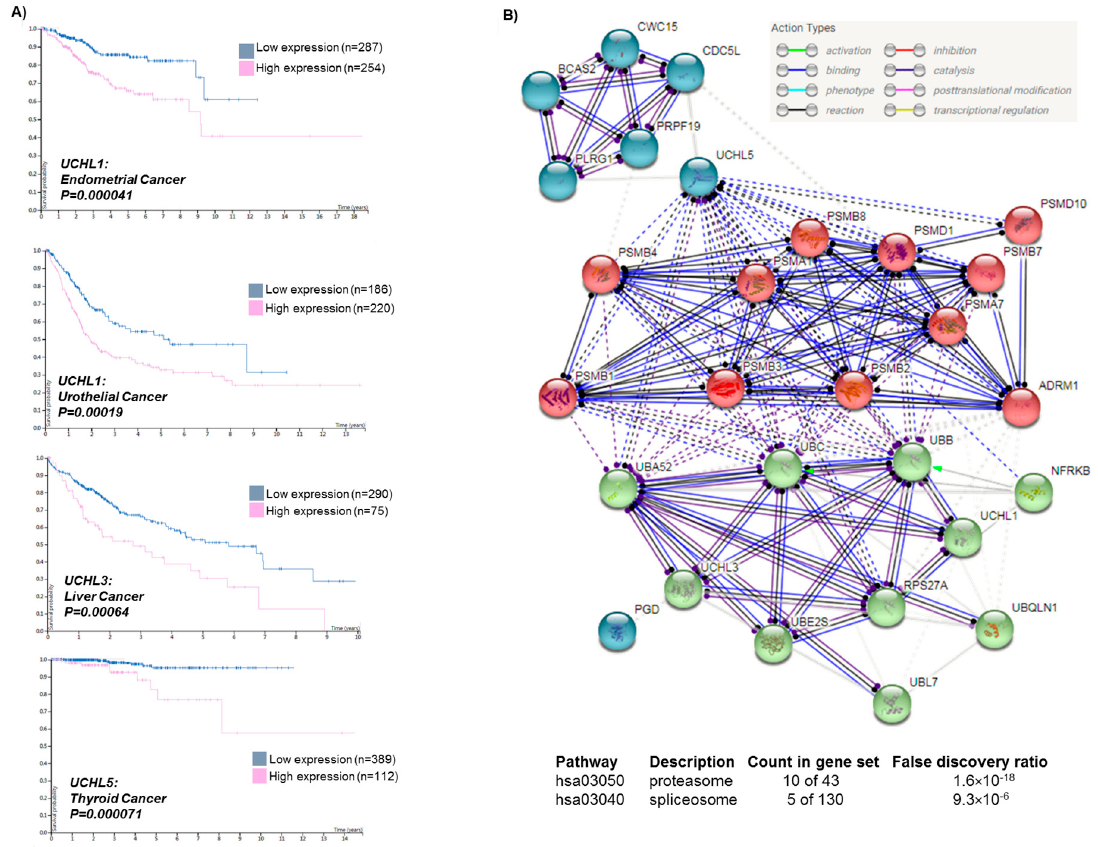
Figure 2. Survival analysis for UCHs in cancer types (for TCGA) and pathway enrichment analysis. ( A ) UCH-L1 as prognostic indicator for the unfavorable outcome in the endometrial and urothelial cancer, while UCH-L3 and UCH-L5 is associated with poor survival in liver and thyroid cancer. Survival di ff erence analysis was done with log-rank test in a Kaplan–Meier survival model. ( B ) Pathway enrichment of UCHs and their functional partners constructed by the String tool is shown. Only the experimentally tested interaction was used for cluster formation, and two main pathways involved in the proteasome and spliceosome are also shown (KEGG ID: hsa03050 and